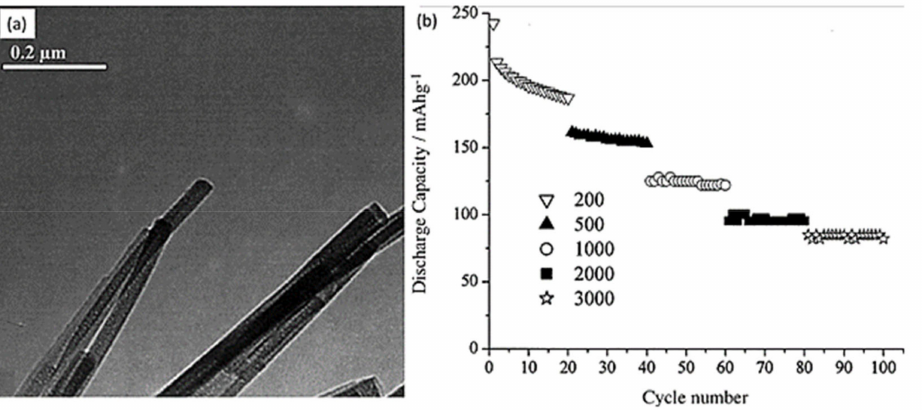
Figure 10. ( a ) TiO 2 -B nanowire TEM image and ( b ) discharge capacities corresponding to cycle num- ber at different current densities. Reprinted with permission from Ref. [72]. Copyright 2005